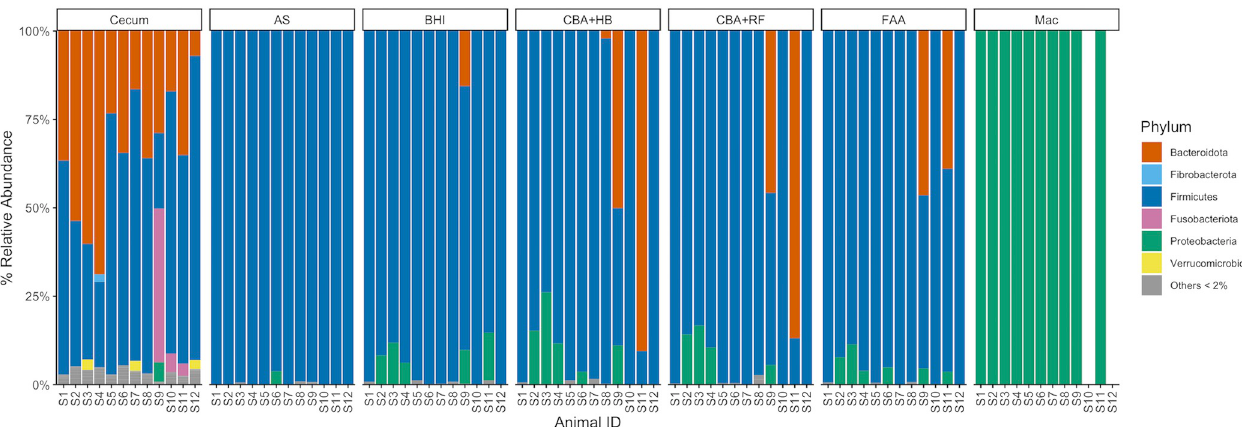
Fig 4. Distribution and relative abundance of bacterial phyla across sample types. Microbiota for each animal ID are partitioned by seven sample types. Bacterial phyla under 2% relative abundance in each sample were grouped. Abbreviations: MacConkey agar (Mac), fastidious agar with horse’s blood added (FAA), Columbia agar with horse’s blood added (CBA+HB), Columbia agar with rumen fluid added (CBA+RF), BHI3 with carbohydrate added (BHI), AS (samples plated on CBA+HB after alcohol shock), and Cecum (samples sequenced directly, without culture). Healthy horses: S1-S6. Acute typhlocolitis horses: